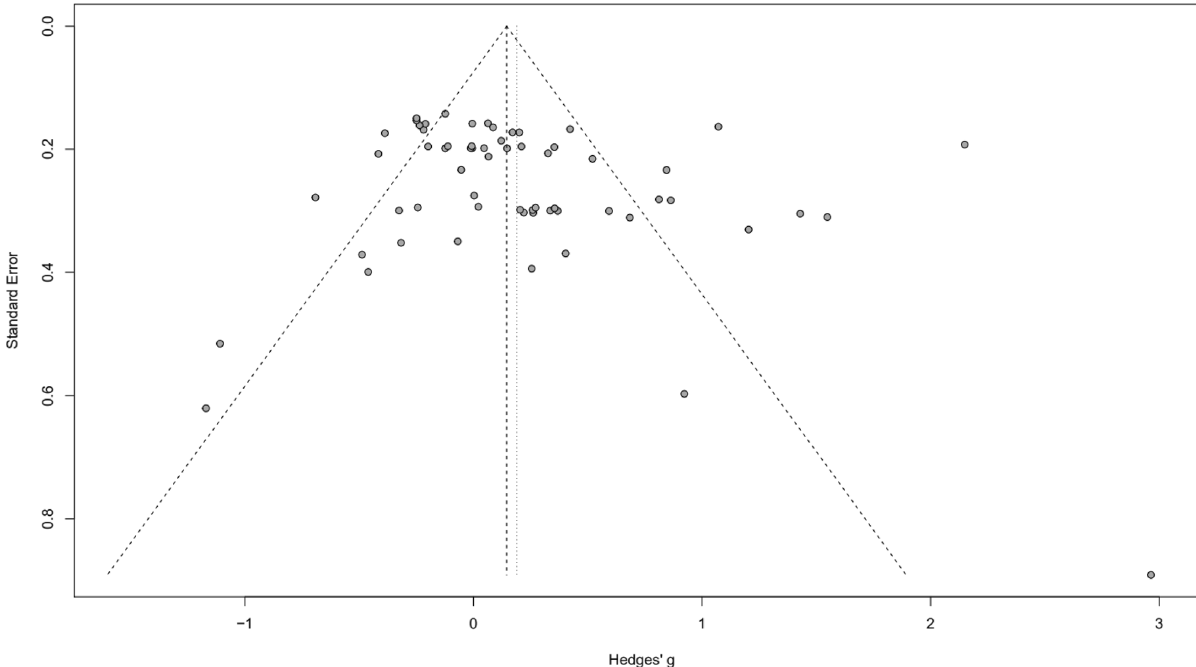
Figure 4. Funnel plot showing symmetry and therefore no publication bias in the papers